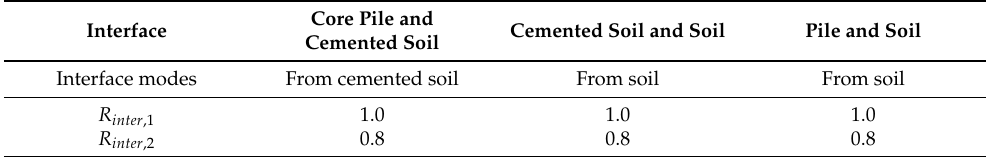
Table 4. Three pairs of interfaces and reduction coefficient R inter .